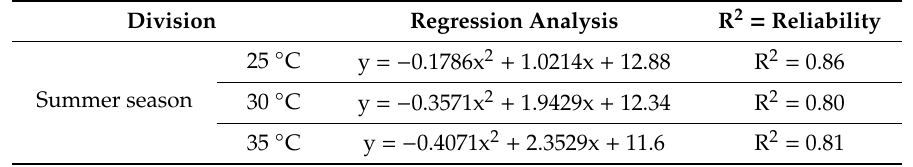
Table 9. Regression analysis results of hot air welding speed according to temperatures in summer. Division Regression Analysis R 2 = Reliability